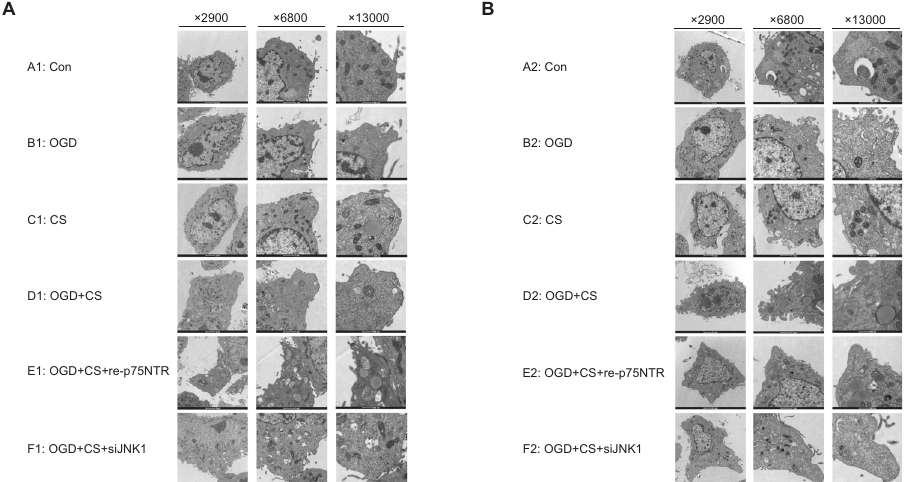
Fig. 4 Electron microscopy of hippocampal and prefrontal cortical neurons (Magni fi cation ×2900, ×6800, ×13,000). A Electron microscopy of hippocampal neurons. B Electron microscopy of prefrontal cortical neurons. Dendrite counts: A1-14, B1-10, C1-8, D1-3, E1-7, F1-9; A2-16, B2- 14, C2-10, D2-2, E2-7, F2-6. Con control, OGD oxygen-glucose deprivation, CS corticosterone. A1: Con; B1: OGD; C1: CS; D1: OGD + CS; E1: OGD + CS + re-p75NTR; F1: OGD + CS + siJNK1; A2: Con; B2: OGD; C2: CS; D2: OGD + CS; E2: OGD + CS + re-p75NTR; F2: OGD + CS + siJNK1.